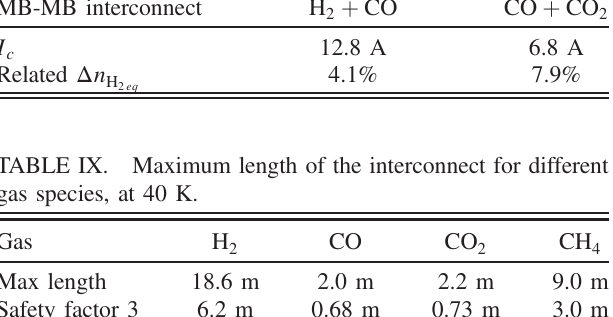
TABLE VIII. Results of I and related gas density increment c for the critical area of the MB-MB FCC-hh interconnection. MB-MB interconnect